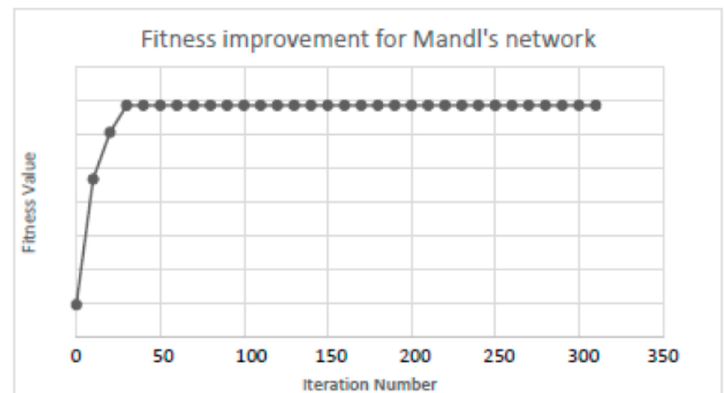
Figure 5. Fitness improvement for Mandl’s network (15 nodes).